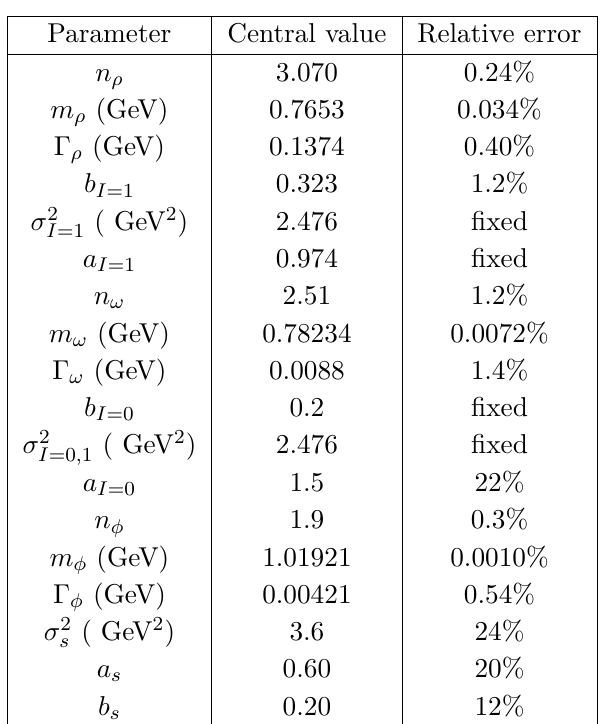
Figure 3 . Vector isovector spectral function from hadronic tau decay data [28–30] compared with our model with parameters given in table 1.